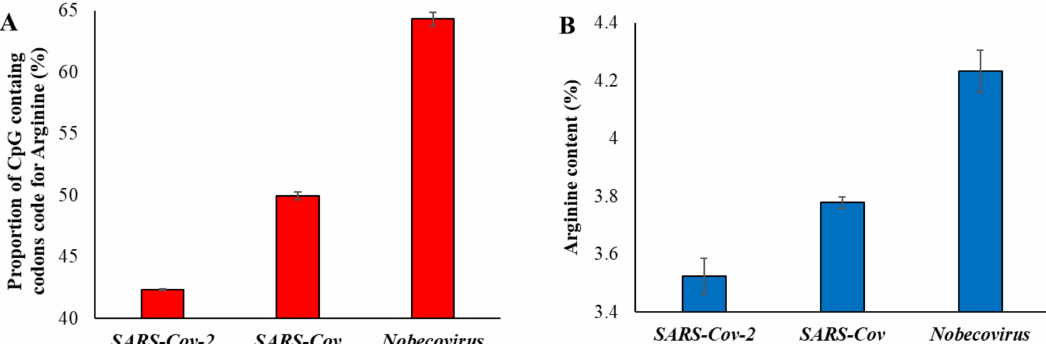
Figure 3. ( A ) Proportion of CpG containing the codons code for the amino acid arginine in three groups of virus genomes. ( B ) Proportion of arginine amino acid present in the exomes of SARS-CoV-2 (and its relatives—dark blue in Figure 1), SARS-CoV (dark green in Figure 1) and Nobecovirus (red in Figure 1). Error bars denote standard error of the